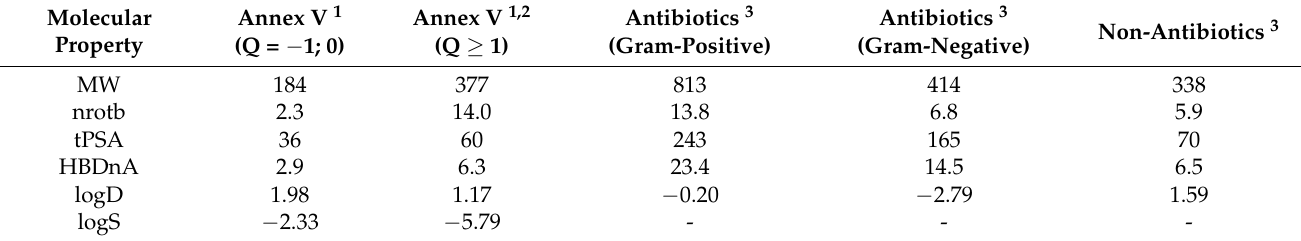
Table 2. Average values of molecular characteristics. Comparison between cosmetic preservatives and antimicrobial drugs.